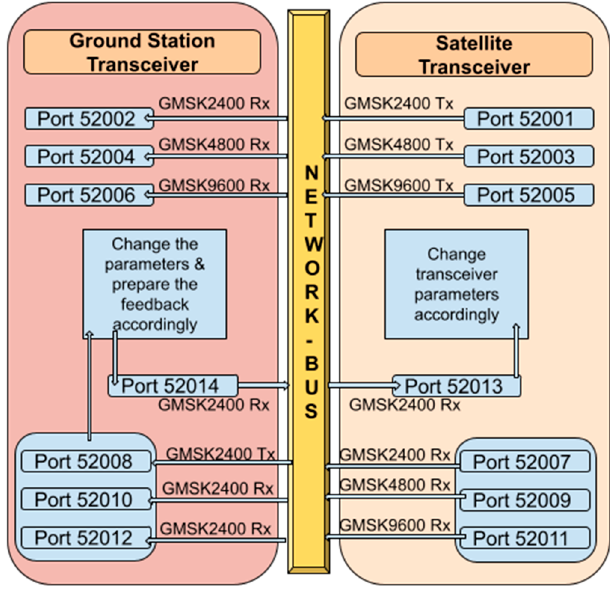
Aerospace 2021 , 4 , x FOR PEER REVIEW Figure 4. Network port utilization. Figure 4. Network port utilization.